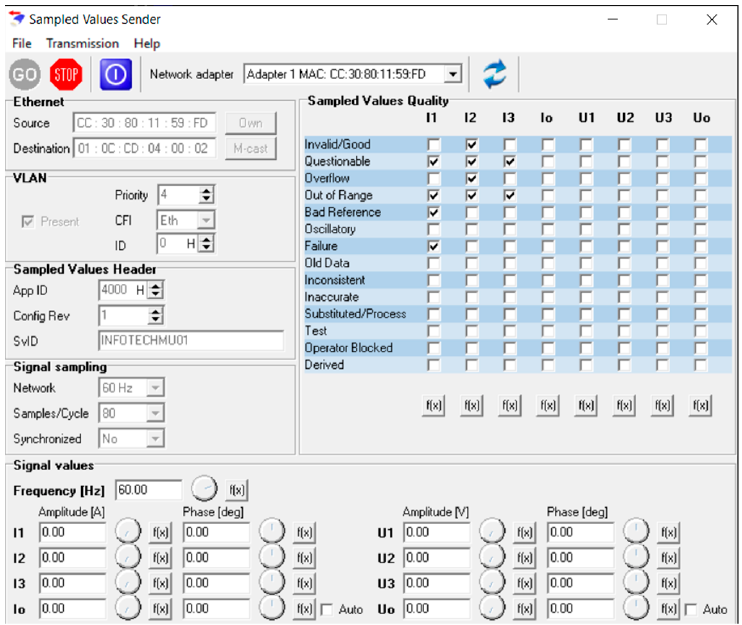
Figure 9. SV message sent from an EV emulator including the SoC, P, and Q values.